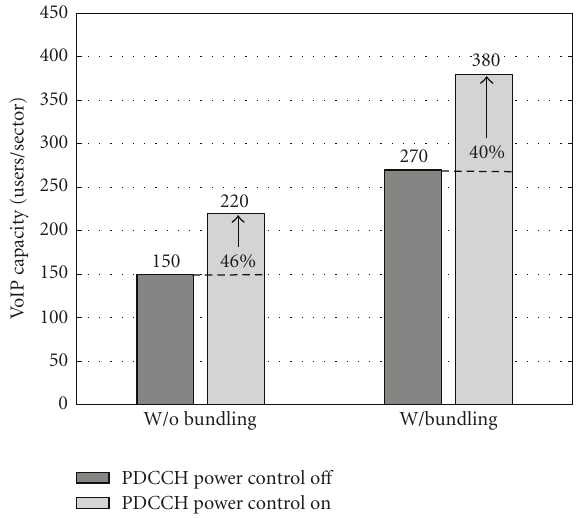
Figure 5: VoIP capacity comparison between without PDCCH power control and with PDCCH power control in 5MHz system bandwidth (Macro Case